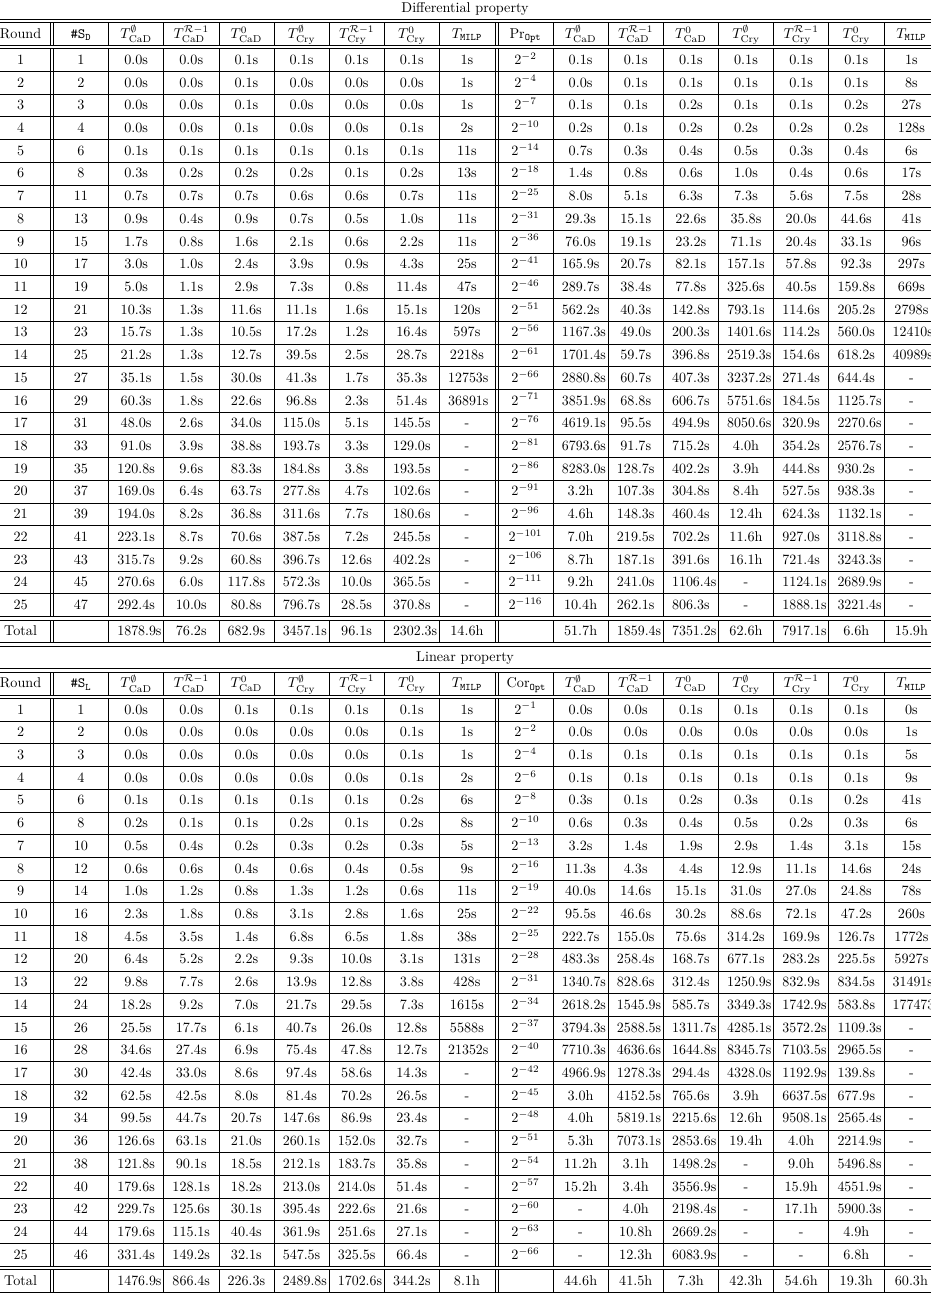
Table 14: Experimental results of RECTANGLE